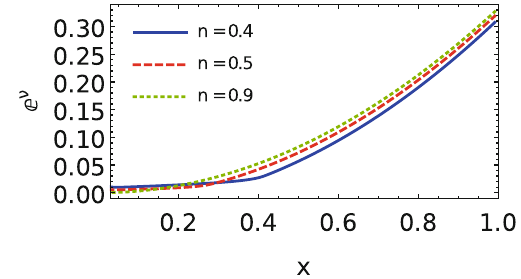
Fig. 4 y as function of n for different values of